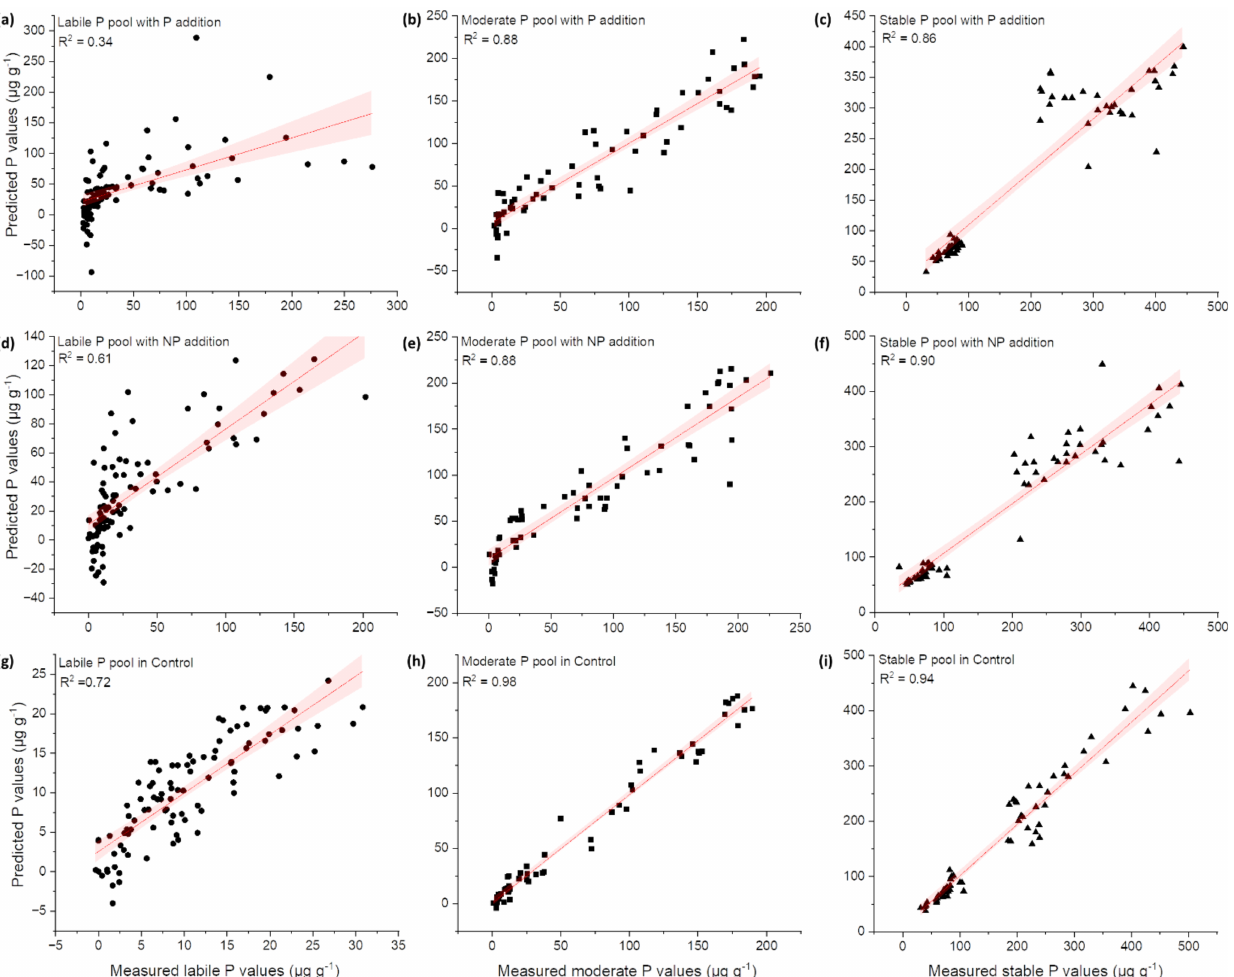
Figure 2. Comparisons of measured P pools (labile P: a , d , g ; moderate P: b , e , h ; stable P: c , f , i ) and the predicted P contents ( µ g g − 1 ) by NIRS modeling with P addition ( a – c ), NP addition ( d – f ), and control ( g – i ). Red lines indicate a significant correlation (all p < 0.05). Shaded areas represent 95% confidence